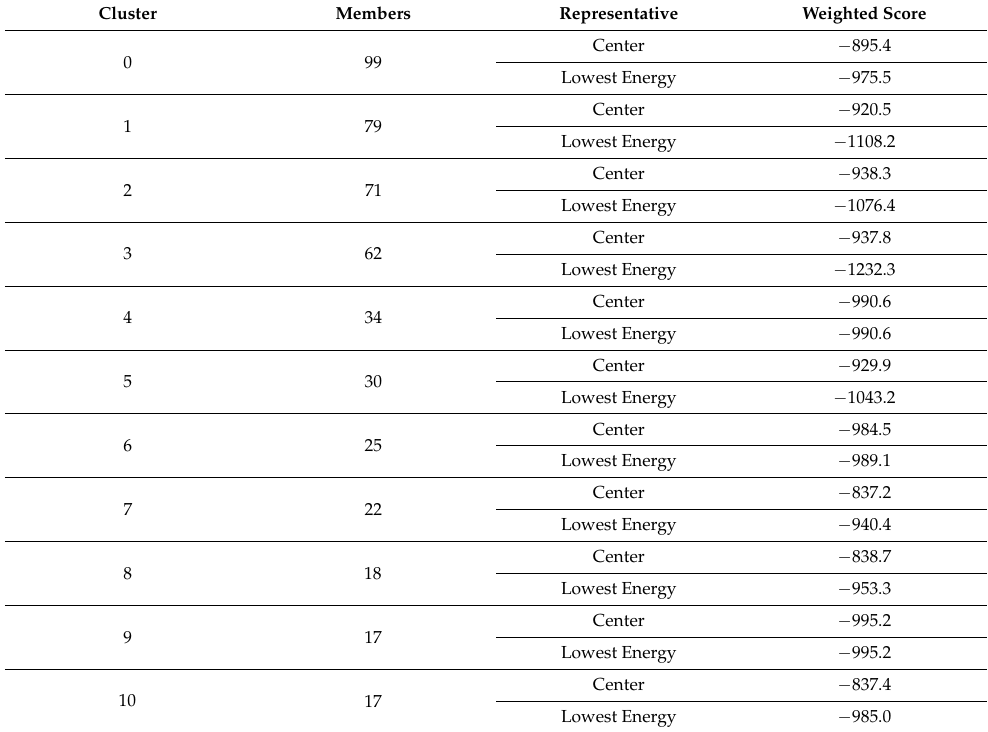
Table 7. Docking score of vaccine-MHC-II